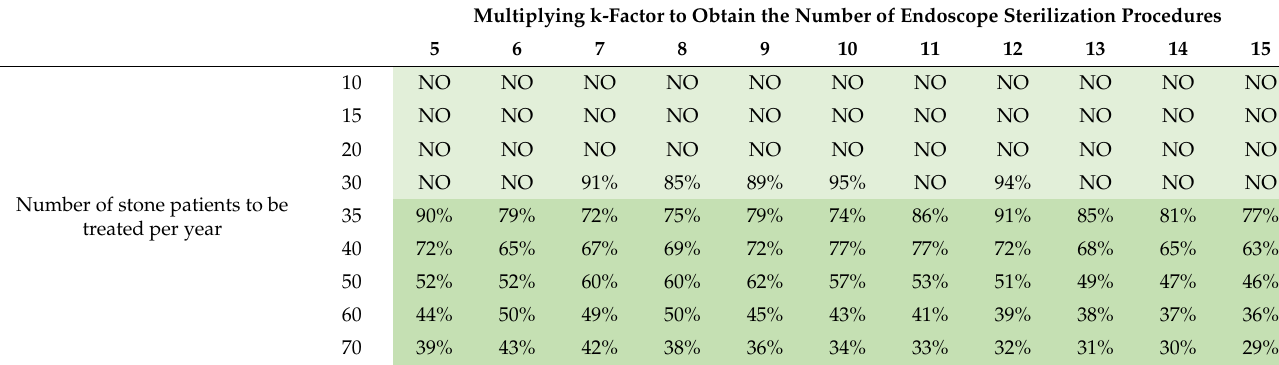
Table 1. Cut-off value for public hospitals in the case of the relevant hybrid